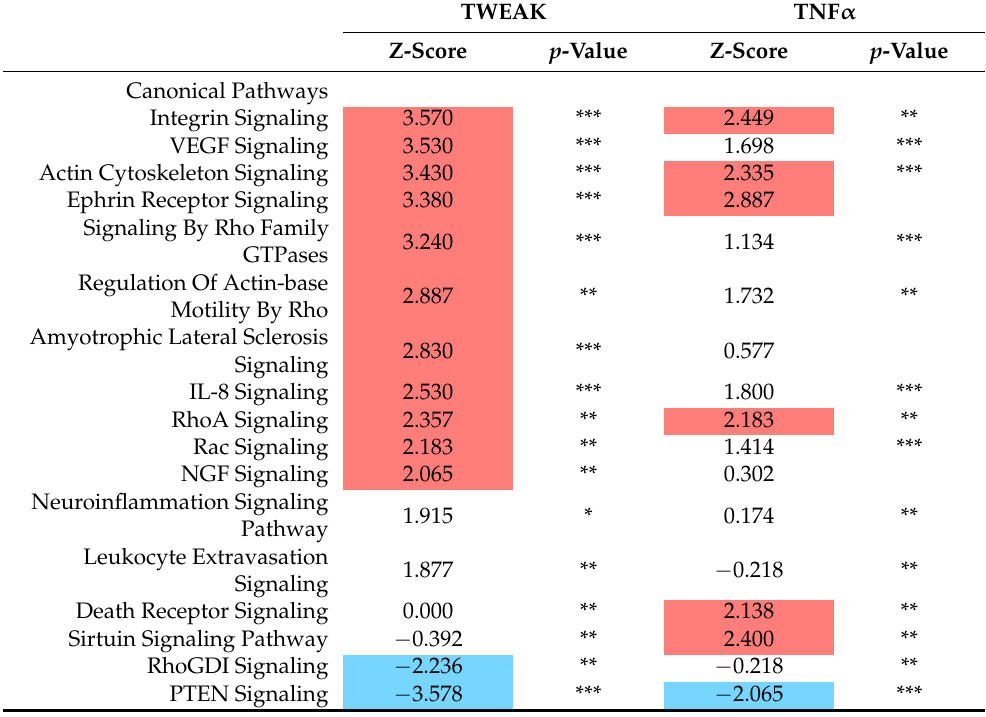
Table 3. Top canonical pathways significantly modulated by 24 h of TWEAK treatment compared to TNF α . Z-score and significance of p -value after 24 h stimulation with TWEAK and TNF α for comparison. Sirtuin signaling pathway and death receptor signaling are included due to their statistical significance after TNF α treatment. Red and blue represent up- and down-regulated pathways, respectively. Results were considered statistically significant when p ≤ 0.05 (*), p ≤ 0.01 (**), or p ≤ 0.001 (***). TWEAK TNF α Z-Score p